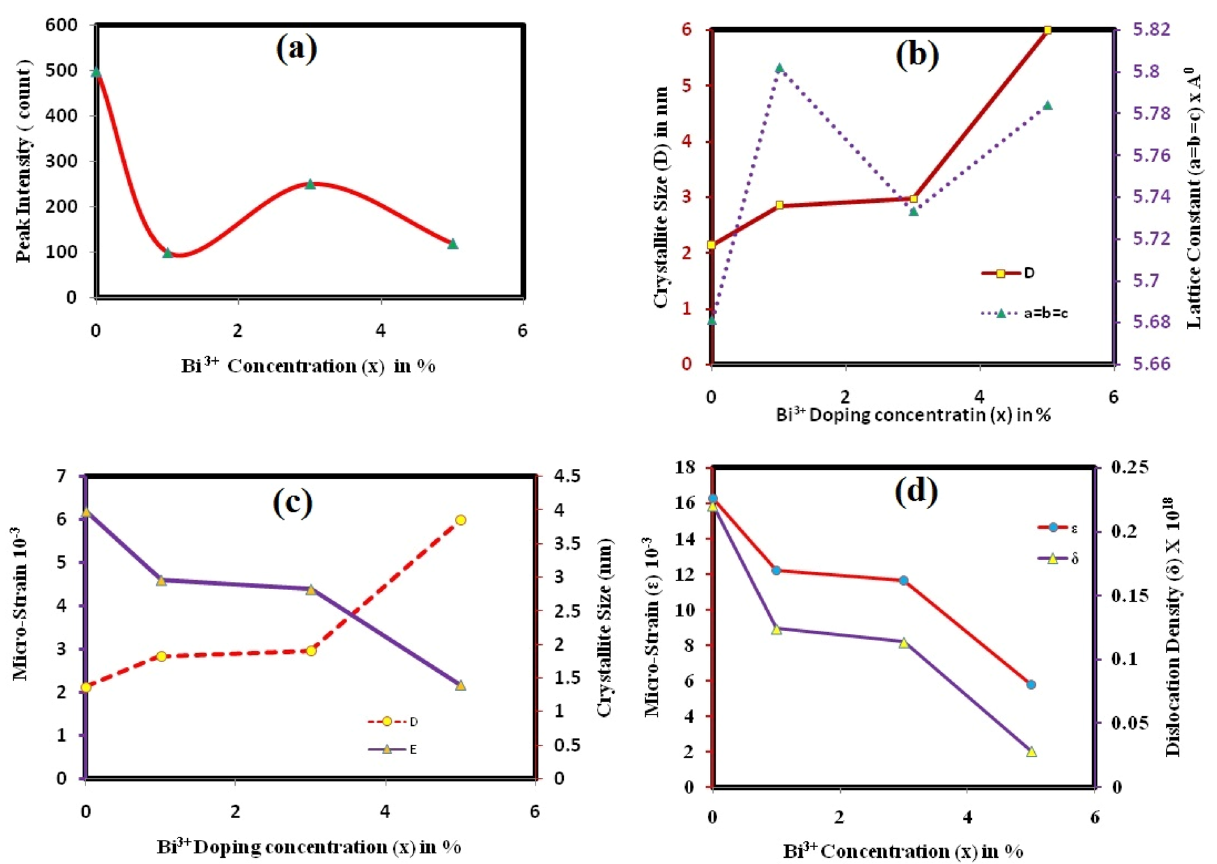
Zn Bi S QDs ( x = 0,1,3 and 5 at. wt. %), b Cd 0.9-x 0.1 x